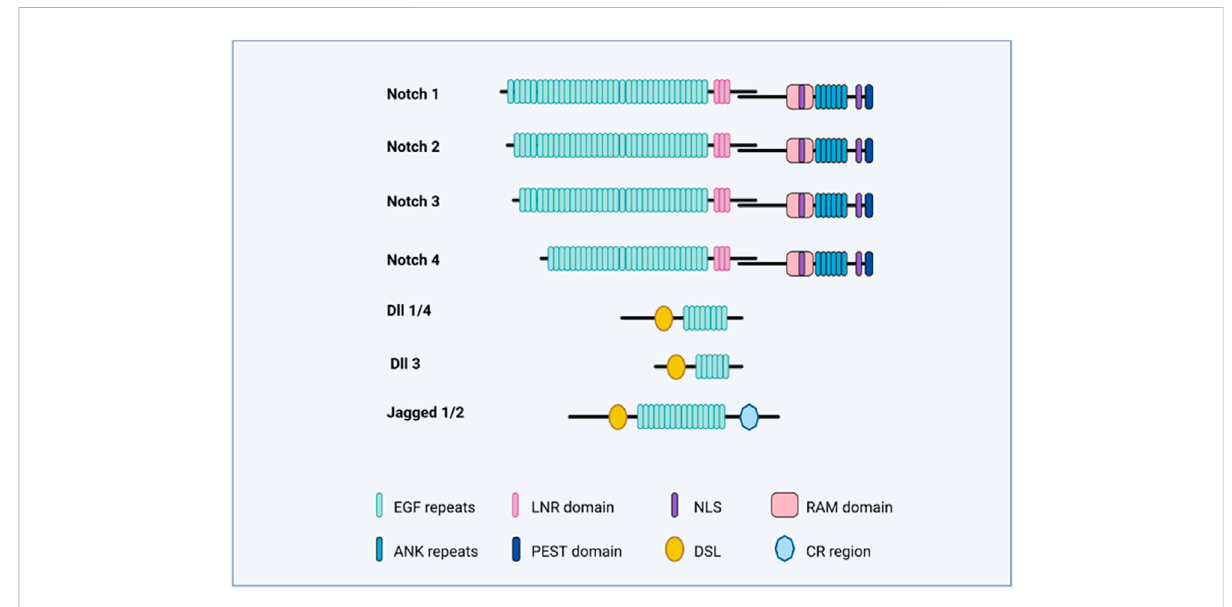
FIGURE 2 Notch-signaling illustration. The fi gure illustrates the domains of Notch receptors (Notch 1 – 4) and Notch ligands ( DLL1 ,3,4; Jag1 and